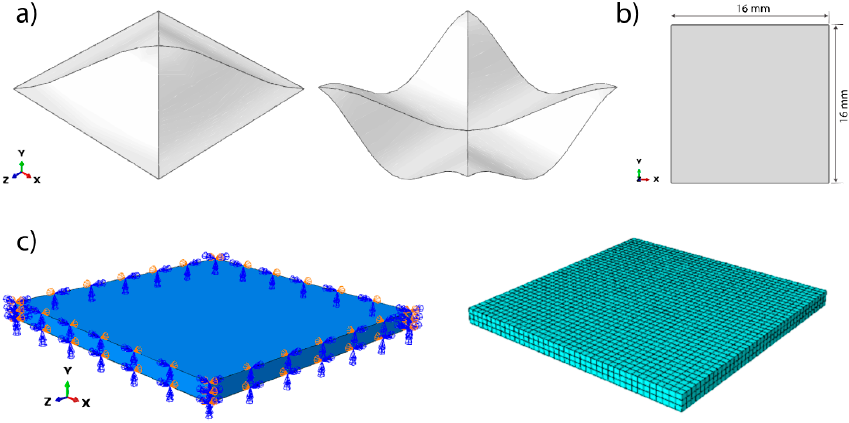
Figure 2. Assembly parts of the numerical simulation of ( a ) the die, ( b ) the sample, ( c ) symmetry of the boundary conditions. The finite element simulation showed that for each RCS process cycle, an effective strain of 0.8, in the most deformed zones of the sample, was applied.